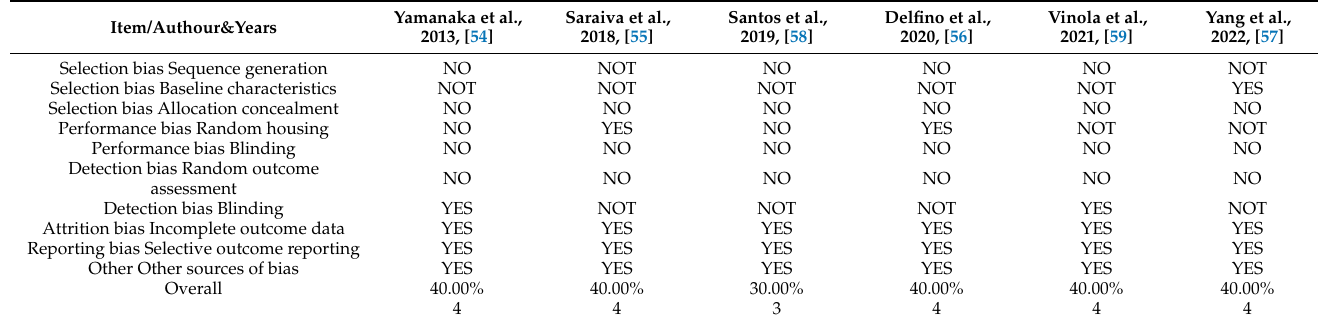
Table 4. Risk of bias of in vivo studies assessed by ‘SYRCLEs RoB